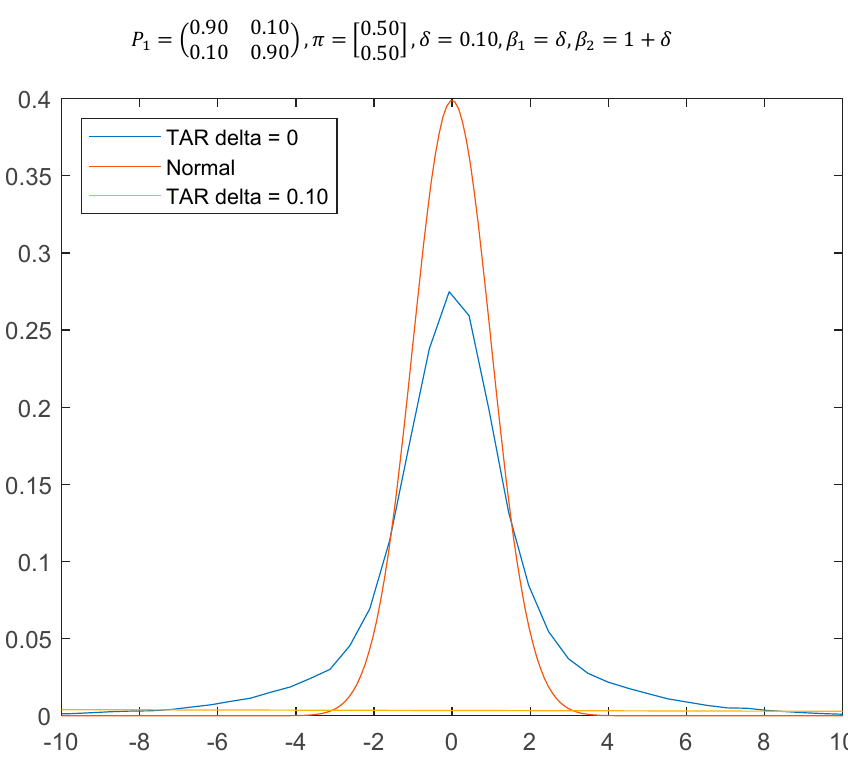
Figure 1. Simulated Distributions for TAR(1) with 𝑃 (cid:2869) as the transition matrix.